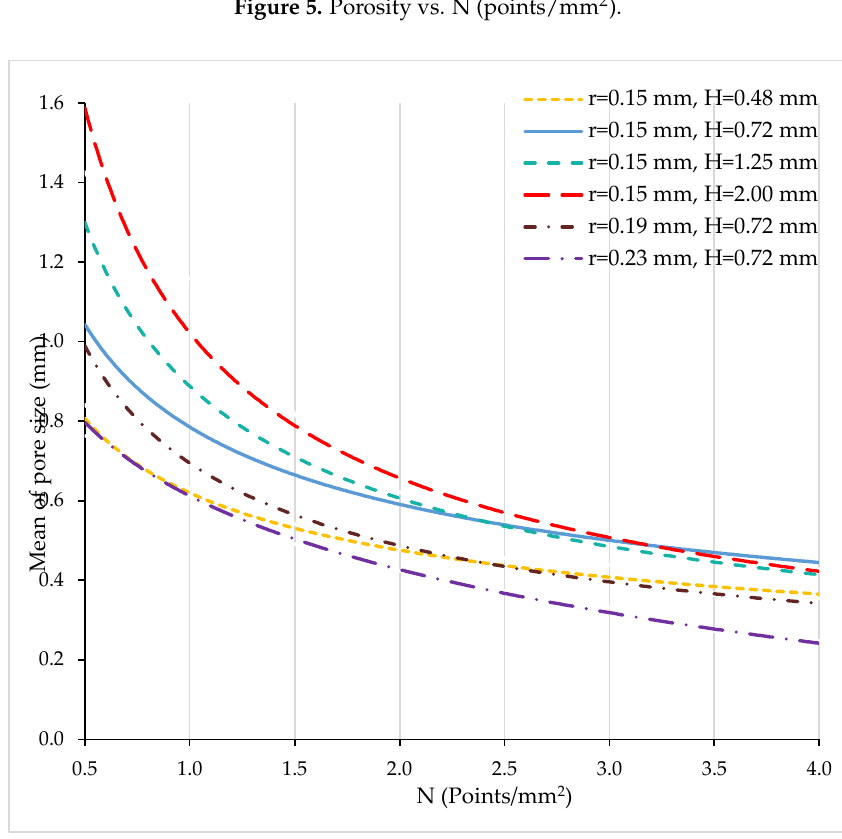
Figure 6. Mean of pore size (mm) vs. N (points/mm 2 ).